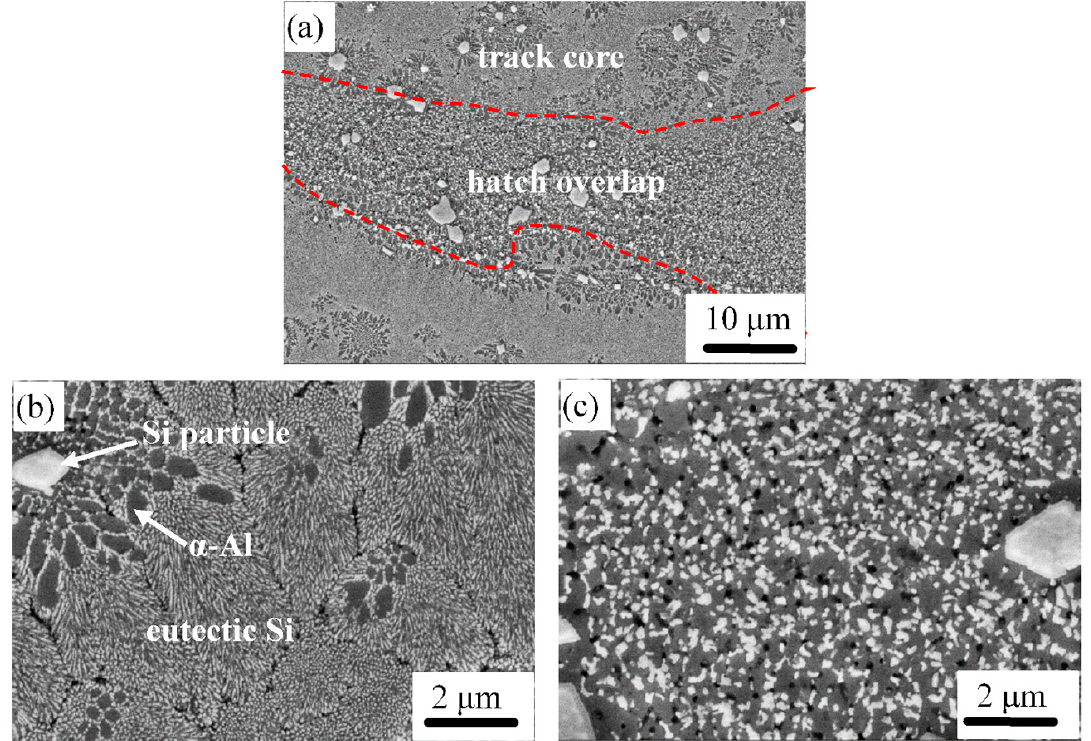
Figure 7. Longitudinal microstructure of the Al–20Si side in the Al–(12-20)Si bi-material, where ( a ) shows the microstructure along with both track cores and hatch overlaps; ( b ) microstructure along with the core of the tracks; and ( c ) microstructure along with the hatch overlaps.